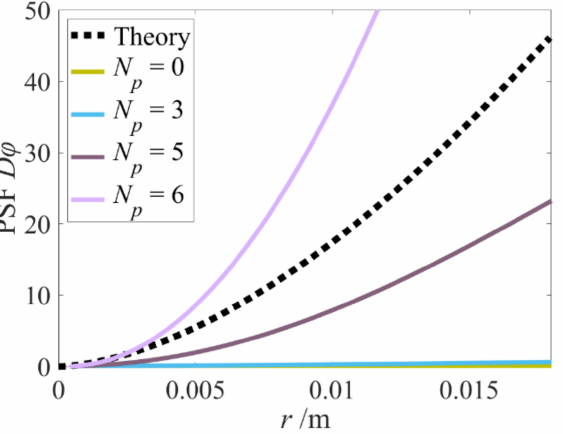
Figure 3. The average PSF of the simulation model with subharmonic phase screens.